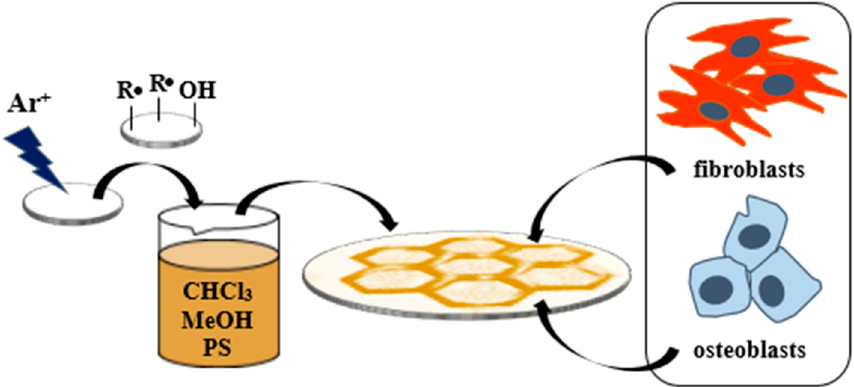
Figure 1. Scheme of the preparation of a polymer scaffold for cell culture.